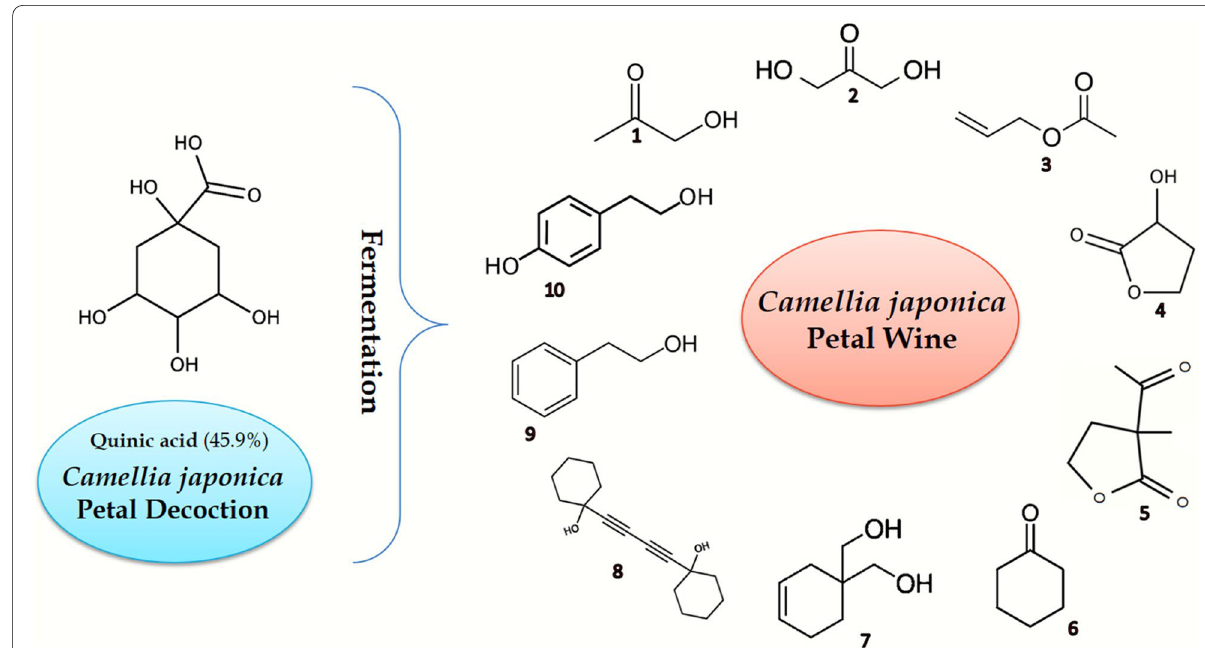
Fig. 9 Proposed biosynthesis pathway of certain CJPW metabolites formed after fermentation-led oxidation of CJPD’s major compound quinic acid. 1: 1-hydroxyacetone (2.96%); 2: dihydroxyacetone (11.55%); 3: acetic acid, 2-propenyl ester (2.46%); 4: 2-hydroxy-gamma-butyrolactone (13.33%); 5: 2-acetyl-2-hydroxy-gamma-butyrolactone (0.27%) 6: cyclohexanone (0.58%); 7: 3-cyclohexene-1,1-dimethanol (1.02%); 8: 1,1 ′ -butadiynylenedicyclohexanol (2.56%); 9: phenylethyl Alcohol (3.03%); 10: tyrosol